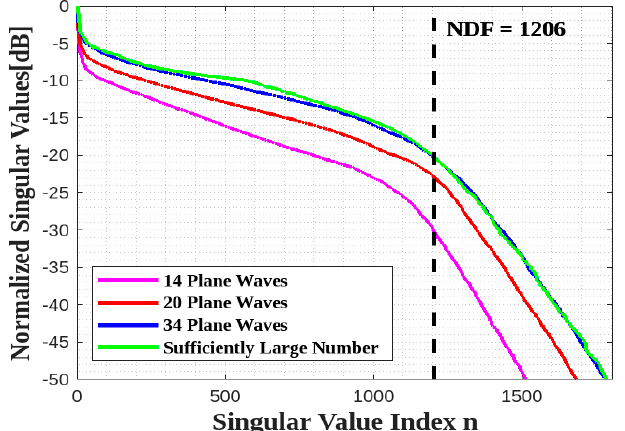
Figure 15. Comparison of the behavior of the normalized singular values for different numbers of impinging plane waves for all sides of a cube ID.